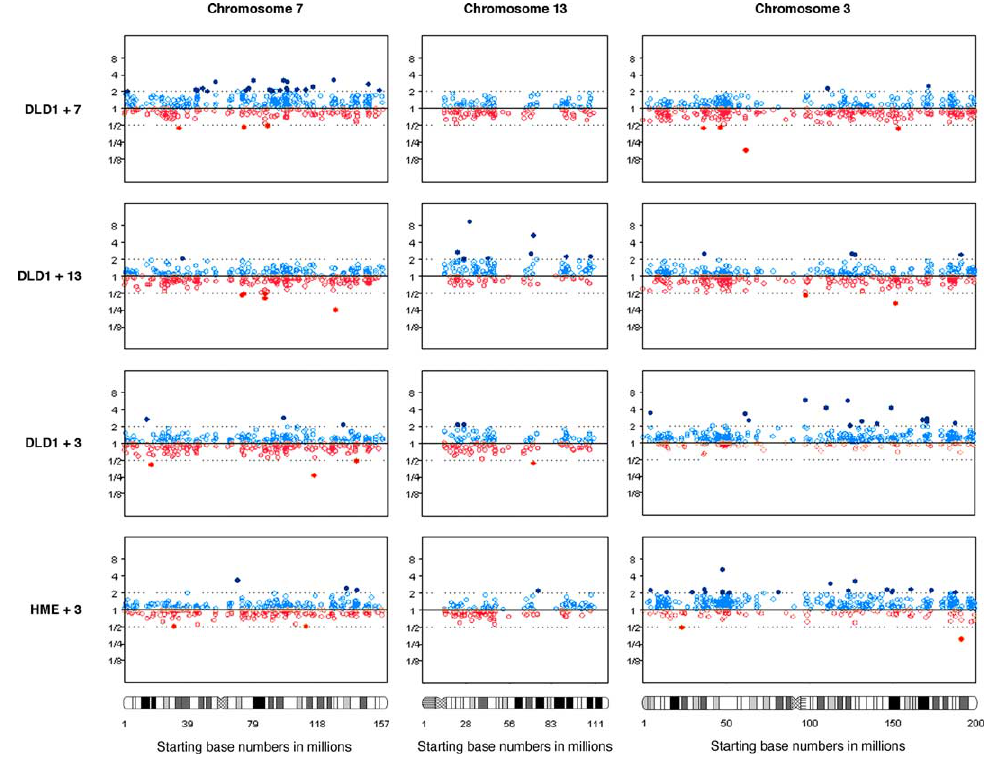
Fig. 3. Global gene expression